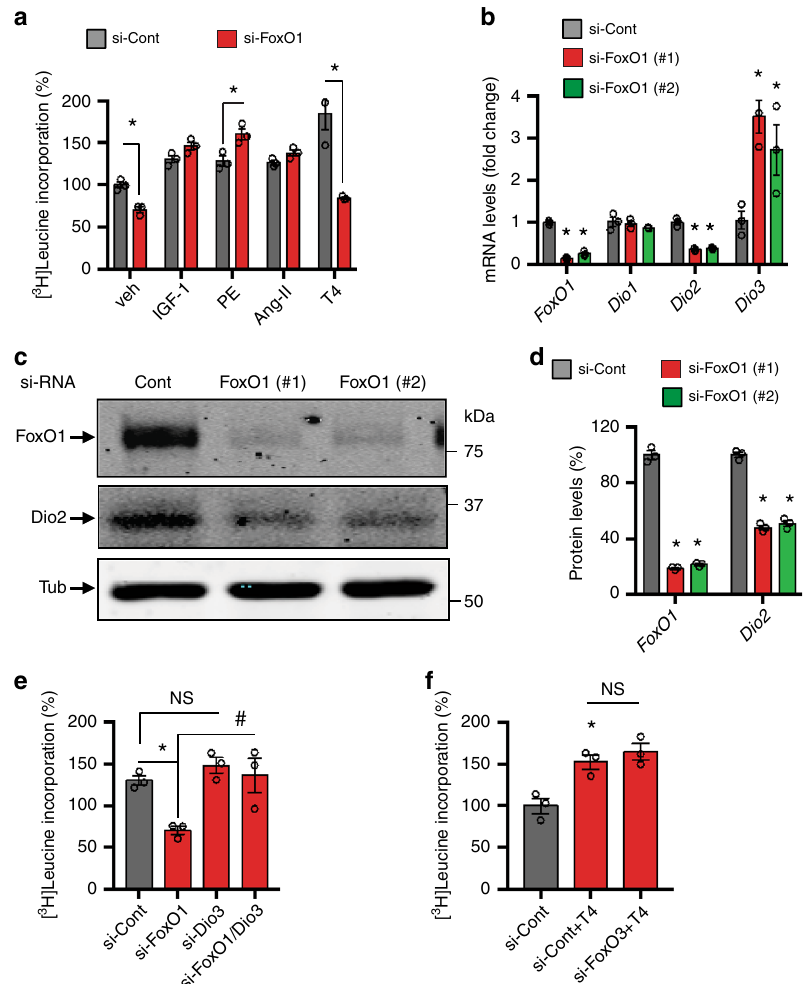
Fig. 1 FoxO1 and Dio2/Dio3 transcriptional circuitry govern TH-induced NRVM growth in vitro. a Selective knockdown of FoxO1 in NRVM speci fi cally abrogated T4-induced hypertrophy but not the cellular growth response triggered by other stimuli. NRVM growth was evaluated by assessing radiolabeled leucine incorporation into protein following 24 h treatment, where NRVM growth in the control (Cont) siRNA- and vehicle (Veh)-treated cells was set to 100%. b Selective knockdown of FoxO1 in NRVM resulted in marked reduction of Dio2 mRNA levels and signi fi cantly induced Dio3 expression. c , d Immunoblotting ( c ) and quantitation ( d ) of FoxO1 and Dio2 levels in FoxO1-de fi cient NRVM. e T3-induced growth response of NRVM transfected with control, Dio3 - and FoxO1 -speci fi c siRNAs alone or in combination. Note that the abrogation of T3-induced NRVM growth response in FoxO1-de fi cient